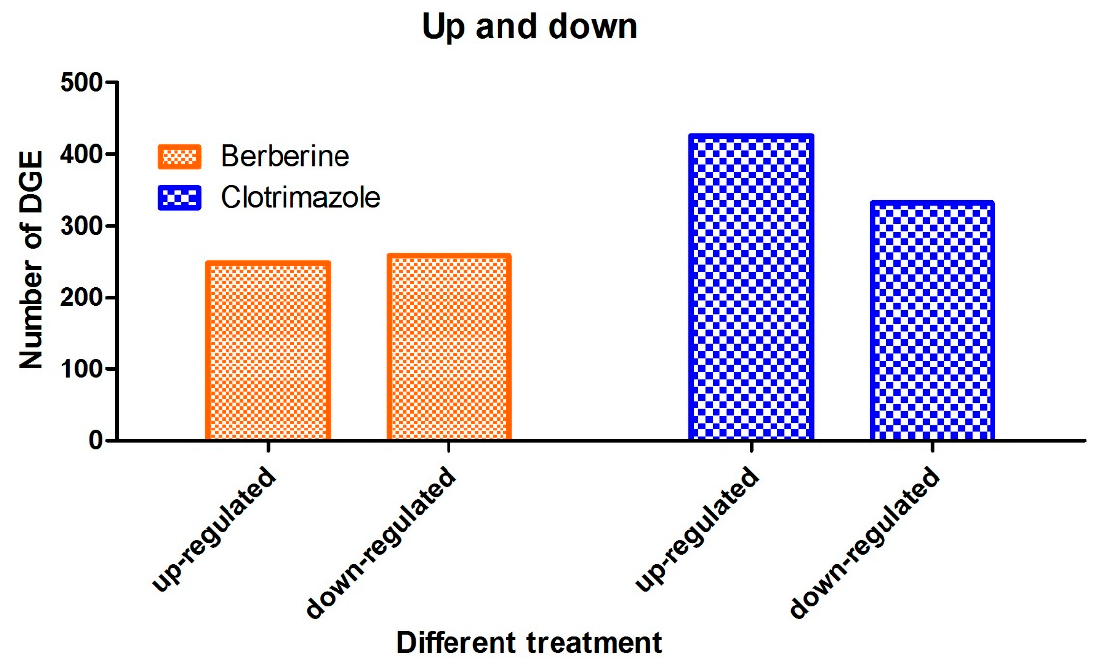
Figure 7. Differentially expressed genes (DEGs) in various groups ( p ≤ 0.05). A total of 506 DEGs were found in the berberine group, including 248 upregulated and 258 downregulated genes, respectively. Meanwhile, 757 DEGs were identified in the clotrimazole group, including 425 and 332 upregulated and downregulated genes,